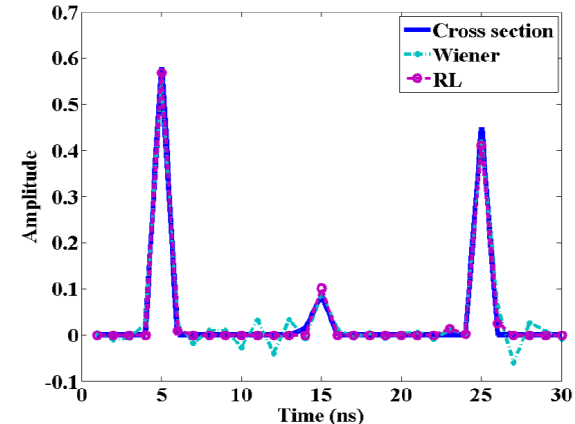
Figure 7. Reconstructed cross sections from the Wiener and RL for data sample 1